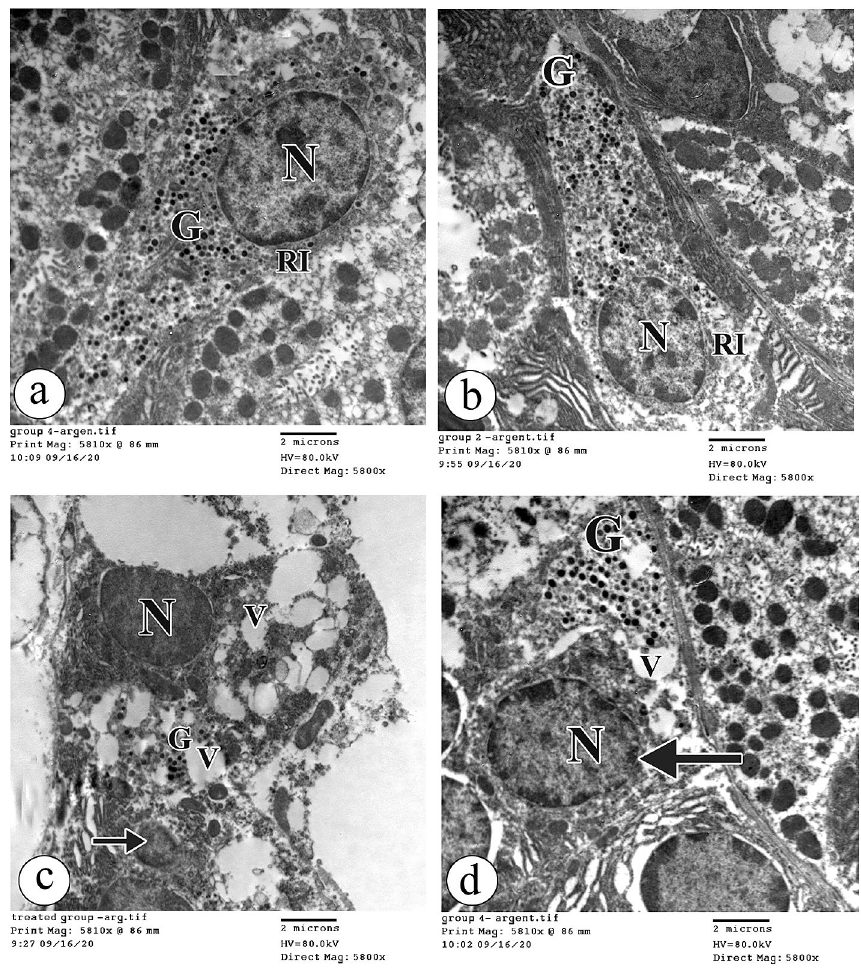
Figure 7. The electron photomicrographs of the enteroendocrine cell in ( a ) the group Ӏ showing an euchromatic nucleus (N) with many tiny electron-dense granules (G) and abundant ribosomes (RI). ( b ) the group ӀӀ showing a similar ultrastructural morphology to that in the group Ӏ . ( c ) the group ӀӀӀ showing an electron dense nucleus (N) and many vacuolations (V). Few tiny electron-dense granules (G) and a loss of cell organelles are noticed. A pyknotic shrunken nucleus (arrow) is seen. ( d ) the group Ӏ V showing an euchromatic nucleus (N) with a nuclear membrane indentation (arrow). The cytoplasm shows many tiny electron-dense granules (G) and vacuolations (V). (TEM × 5800, Scale bar = 2